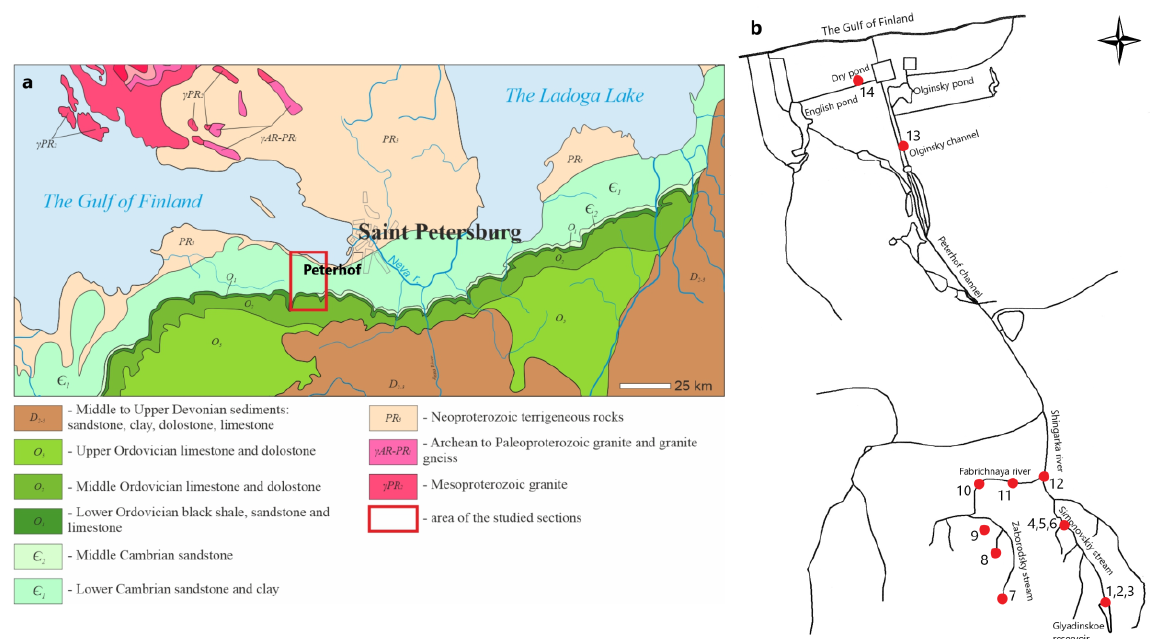
Figure 2. Characteristic of the studied area and sampling points: ( a )—simplified geological map of the Leningrad region (following [24], with changes); ( b )—schematic map of sampling points, numbers corresponding to Table 1.